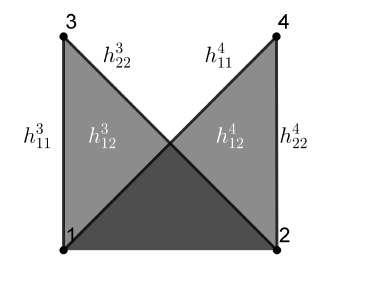
Figure 1. Example